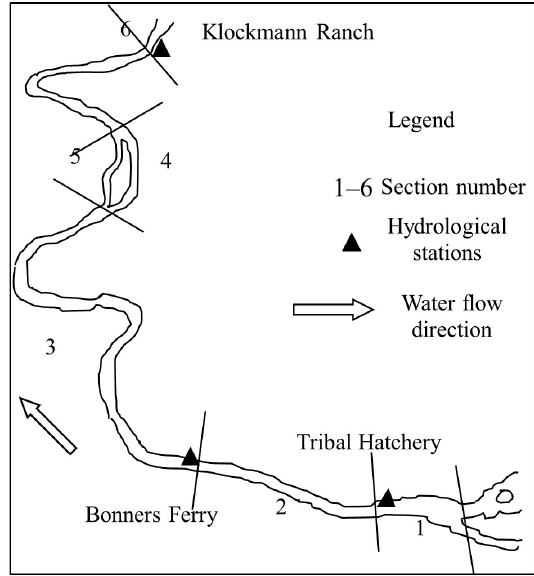
Figure 4. Schematic diagram of the Kootenai river.